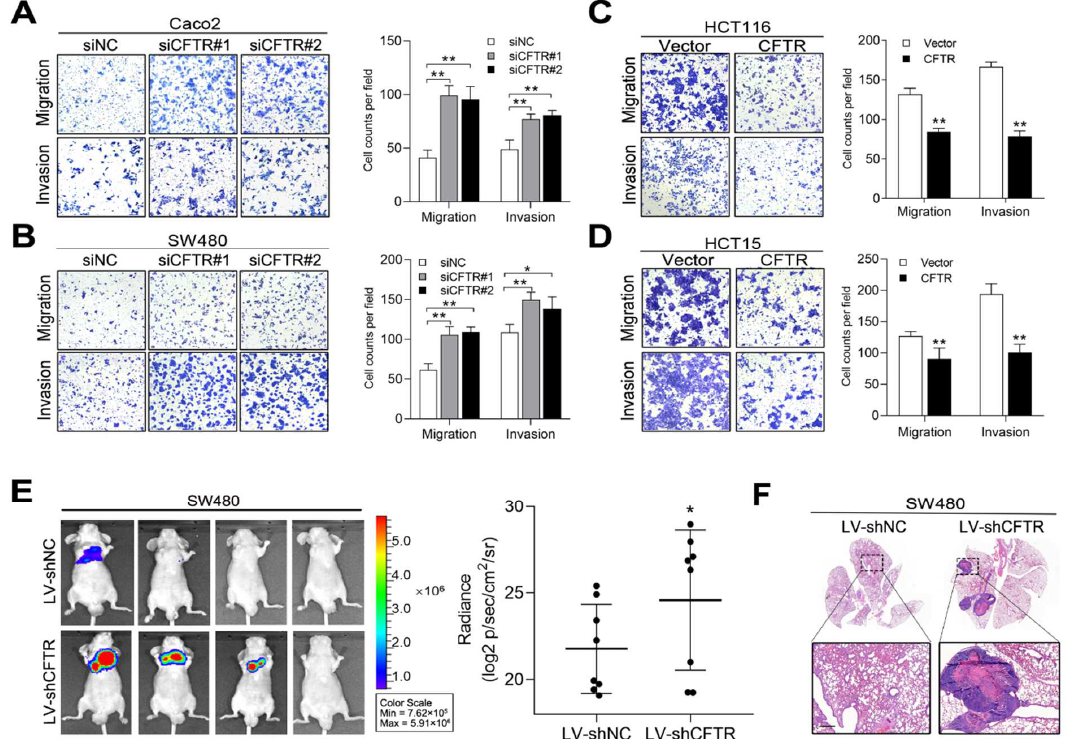
Figure 4. CFTR inhibits CRC metastasis in vitro and in vivo. ( A , B ) Silencing CFTR expression by small interfering RNAs (siRNAs) promoted migration and invasion in Caco2 ( A ) and SW480 ( B ) cells. ( C , D ) Overexpression of CFTR inhibited migration and invasion in HCT116 ( C ) and HCT15 ( D ) cells. ( E ) Bioluminescent images and radiance values of mice ( n = 8) injected with SW480 cells infected with lentiviral short hairpin RNA against CFTR (LV-shCFTR) or negative control (LV-shNC). ( F ) Representative H&E staining images of lung tissue sections from the indicated groups. Scale bars represent 500 μm. * p < 0.05, ** p < 0.01 by the Student’s t -test.